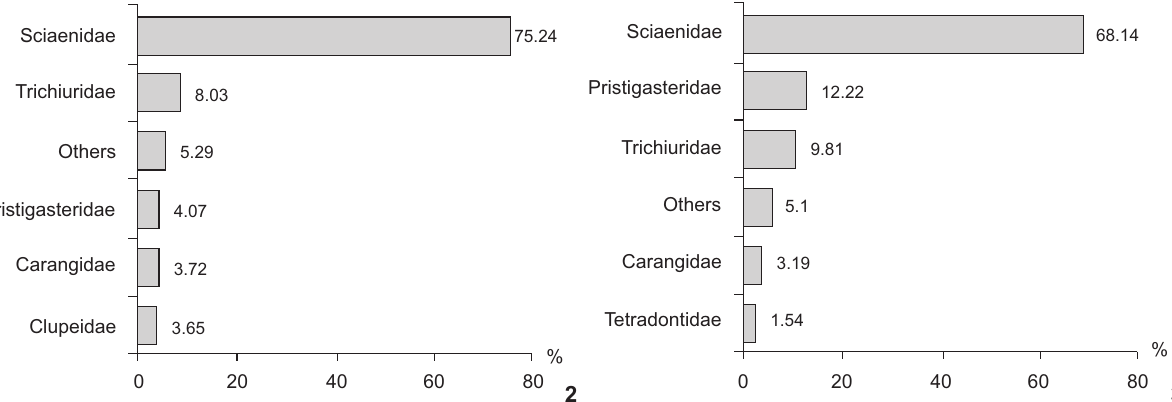
Figures 2-3. Percentage abundance participation of the collected fish families in the accompanying fauna from seabob shrimp fishery in Balneário Barra do Sul (2) and Penha (3).